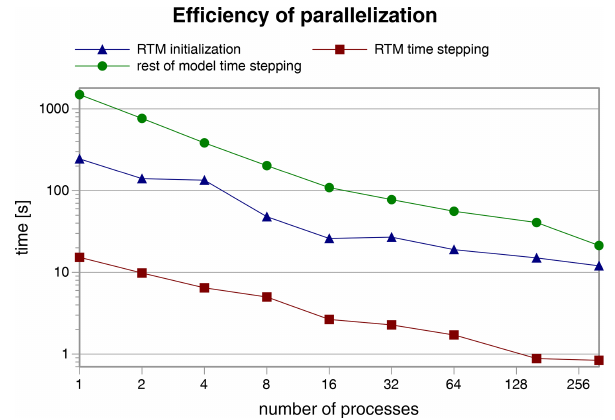
Figure 10. A double-logarithmic presentation of computational time versus the number of processes for a small scenario, typically suitable for 16–32